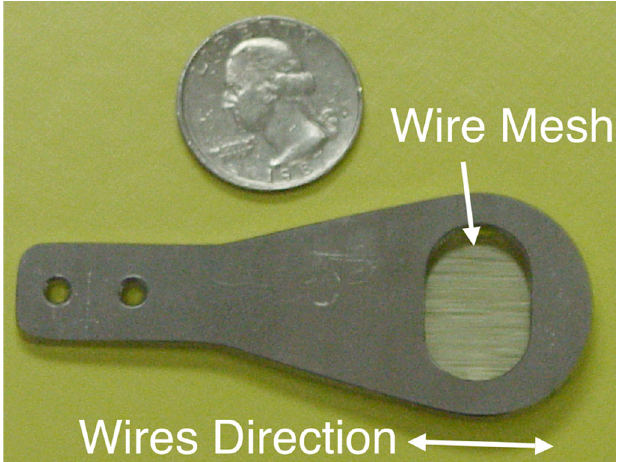
s ¼ 16 : 6 m in Fig. 1. After exiting the dogleg, the beam propagates over a dispersion-free distance of (cid:1) 6 : 5 m , where experiments can be performed, before entering a magnetic spectrometer. Before the dogleg, the bunch L z is about 1650 (cid:8) m long (or (cid:1) 5 : 5 ps , full width of the core). The dogleg longitudinal dispersion function R 56 is (cid:1) (cid:3) 4 cm , which means that the effect of the dogleg is to either compress or stretch the bunch by (cid:5) 400 (cid:8) m (or (cid:5) 1 : 3 ps ) per percent of correlated energy spread, depend- ing on the sign of the spread (or slew). A bunch with higher (lower) energy particles in the front (back) is compressed (stretched) by the dogleg, and therefore has a positive (negative) correlated energy spread: (cid:1) E=E 0 > ð < Þ 0 . The R ds 0 (cid:7) ð s 0 Þ dogleg R 56 is defined as: R 56 ¼ , where (cid:9) ð s 0 Þ is (cid:9) ð s 0 Þ the local radius of curvature of the beam trajectory.